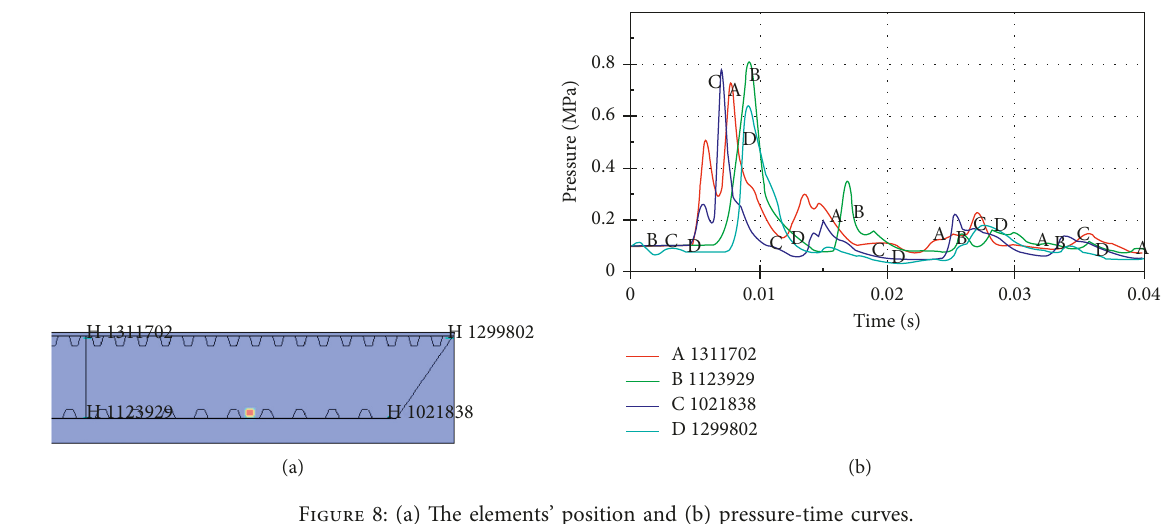
Figure 8: (a) The elements’ position and (b) pressure-time curves.